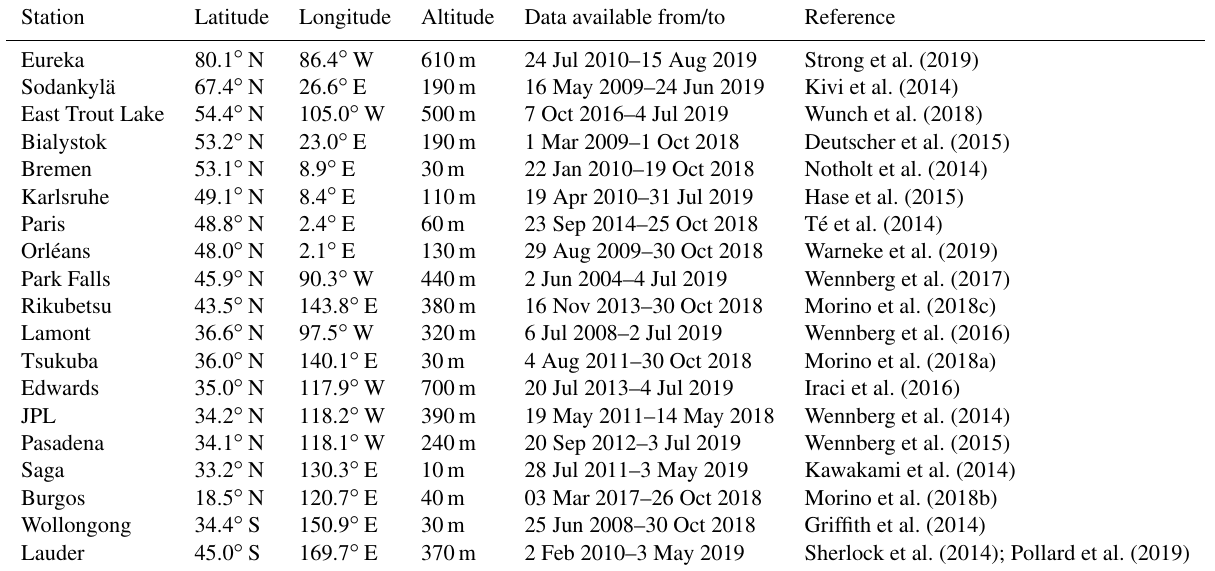
Table 1. List of TCCON stations used for the